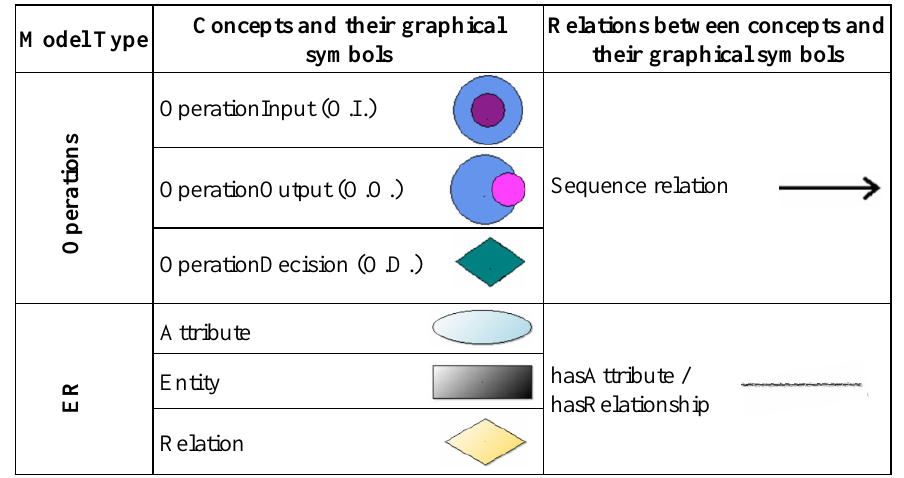
Table 1. Metamodel concepts and their graphical